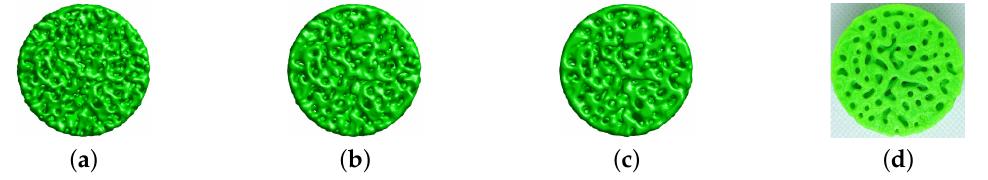
Figure 8. Temporal phase separation with f ( x , y , z ) = 0.2 − 0.4/ ( x 2 + y 2 + 1 ) at ( a ) t = 50 ∆ t , ( b ) t = 100 ∆ t , and ( c ) t = 200 ∆ t . ( d ) 3D printed model of zero level isosurfaces of φ at t = 200 ∆ t